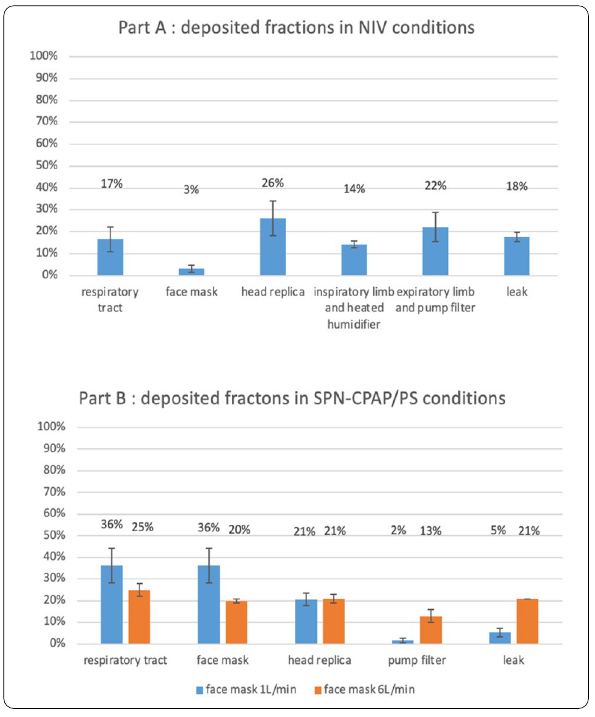
Figure 1: for PART A and PART B, results express in % of nominal dose, mean and standard deviation. FC‑147 Clinical impact of the oximeters’ inaccuracy (bias and errors)— secondary analysis of the oxygap